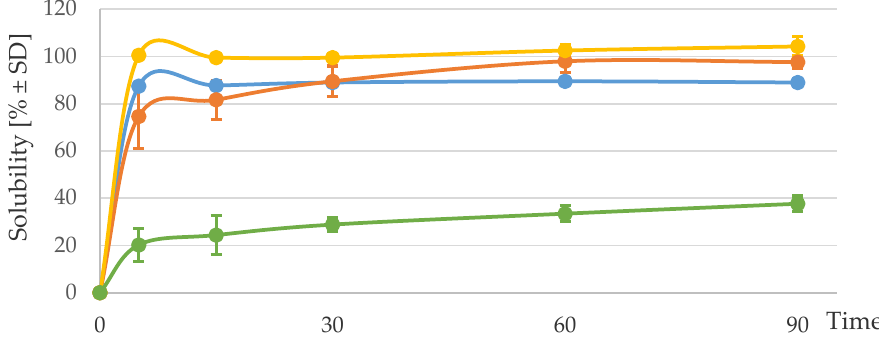
Figure 1. Solubility (% ± Standard deviation (SD)) of iron salts and of iron from the two batches of iron-casein complex at pH 1.7 over time. The solubilities of ferrous sulfate, micronized ferric pyrophosphate, iron-casein complex (2.9%), and iron-casein complex (2.8%) are represented by (- • -), (- • -), (- • -) and (- • -), respectively.